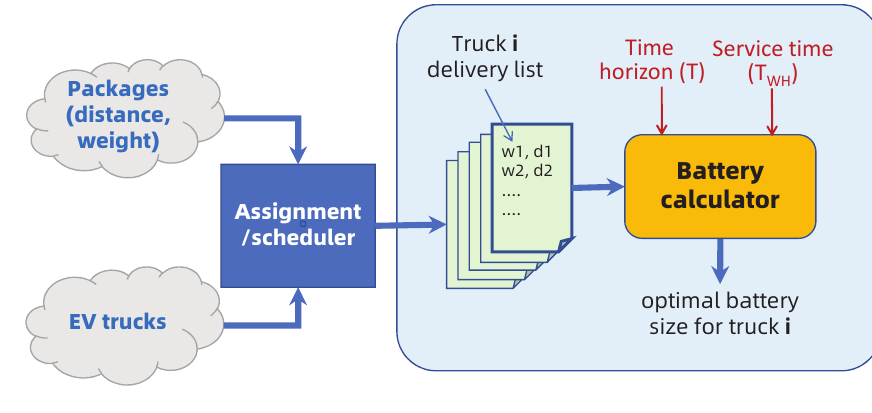
Figure 2. General scenario of our